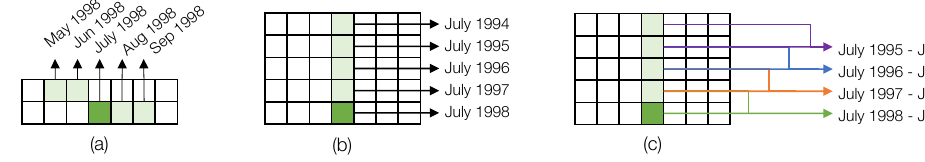
Figure 3. Examples of the three proposals for the load mechanism to predict the climate variable of July 1999 (index 1 starts from the top left of P ). ( a ) Nearby-Time representation with the nearby representation of 2, ( b ) Periodic-Depth representation with a depth of 5, and ( c ) Periodic-Depth- Differencing representation with a depth of